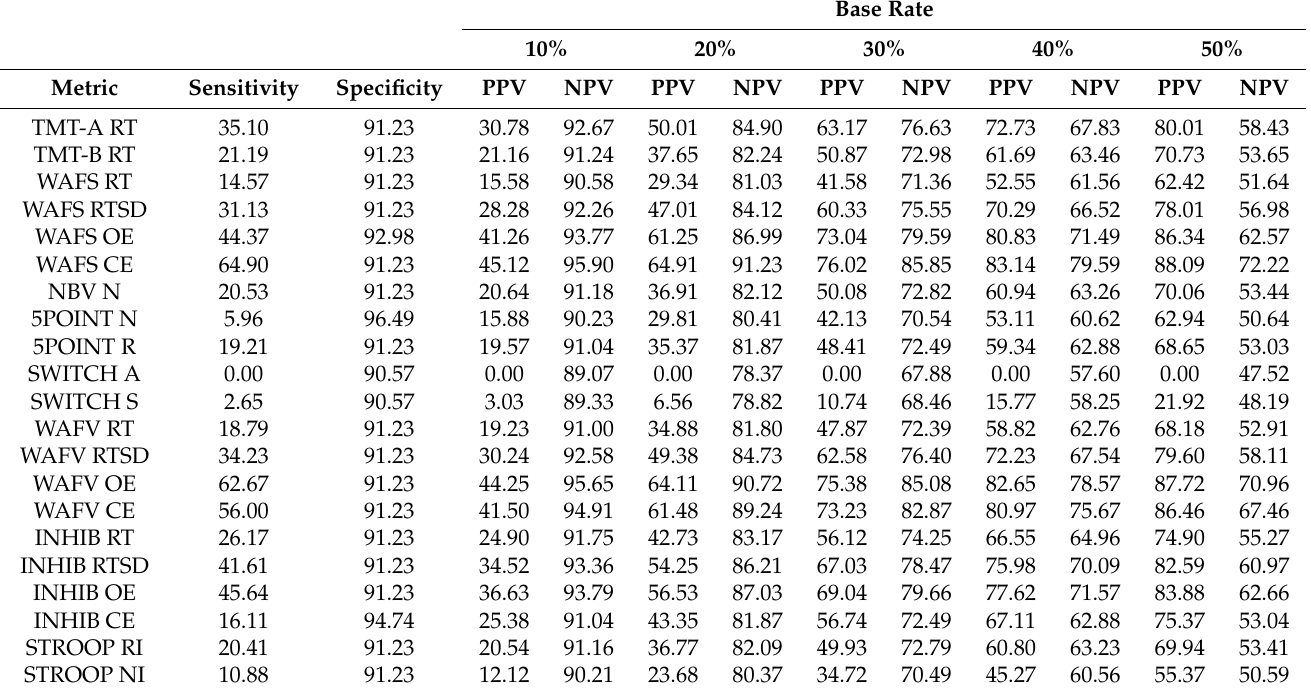
Table 4. Sensitivity, Specificity, and Positive (PPV) and Negative Predictive Values (NPV). Base Rate 10%